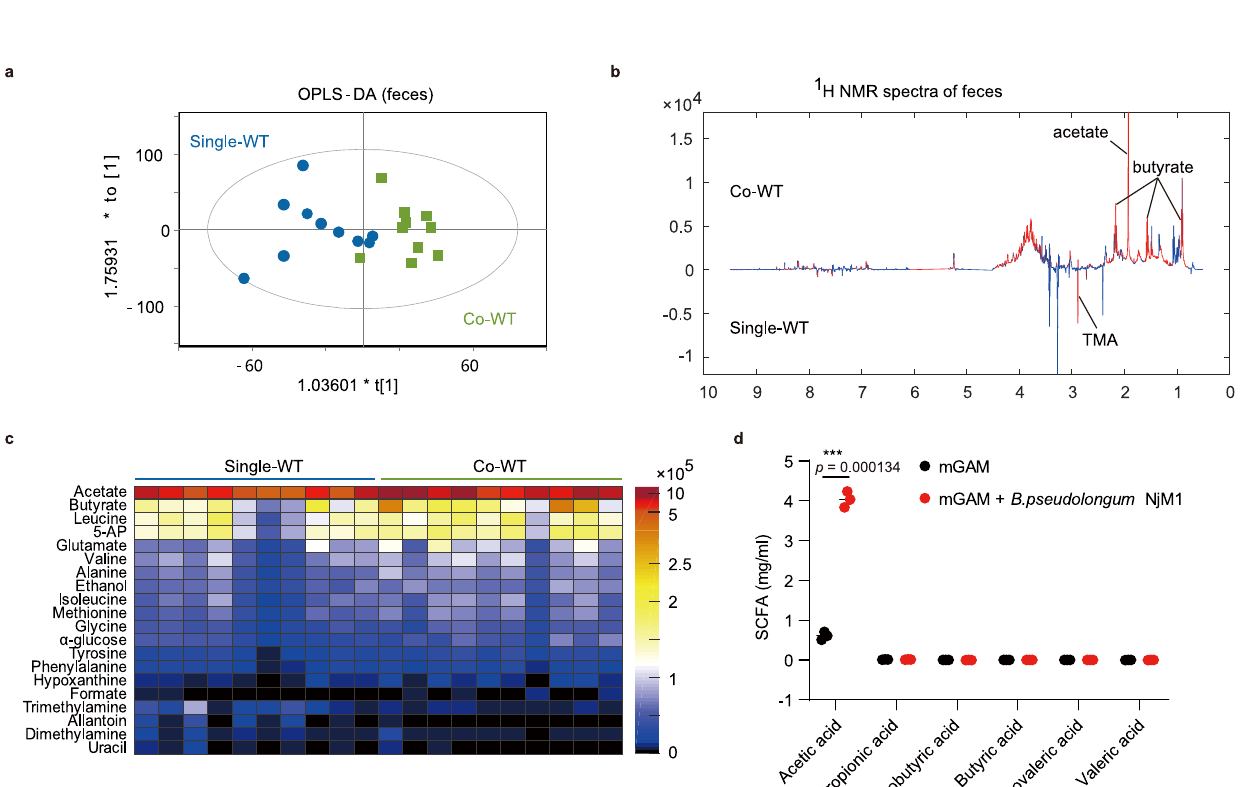
Fig.1|Commensalmicrobiotafrom Nlrp3 − / − miceenhanceshostdefenseagainst in fl uenza A virus infection in WT animals. a Nlrp3 − / − and WT mice either singly housed or co-housed were intranasally infected with PR8. The body weights and survival rates were assessed. Single-WT ( n =12), Single- Nlrp3 − / − ( n =12), Co-WT ( n =18), Co- Nlrp3 − / − ( n =18). b All groups of mice as in ( a ) were given antibiotics, then infected and assessed as in ( a ). Single-WT ( n =12), Single- Nlrp3 − / − ( n =9), Co- WT ( n =11), Co- Nlrp3 − / − ( n =11). c – g Fecal microbiota composition was assayed for (LEfSe) v1.0 ( n =5 per group). The cluster tree on the left of each heatmap shows